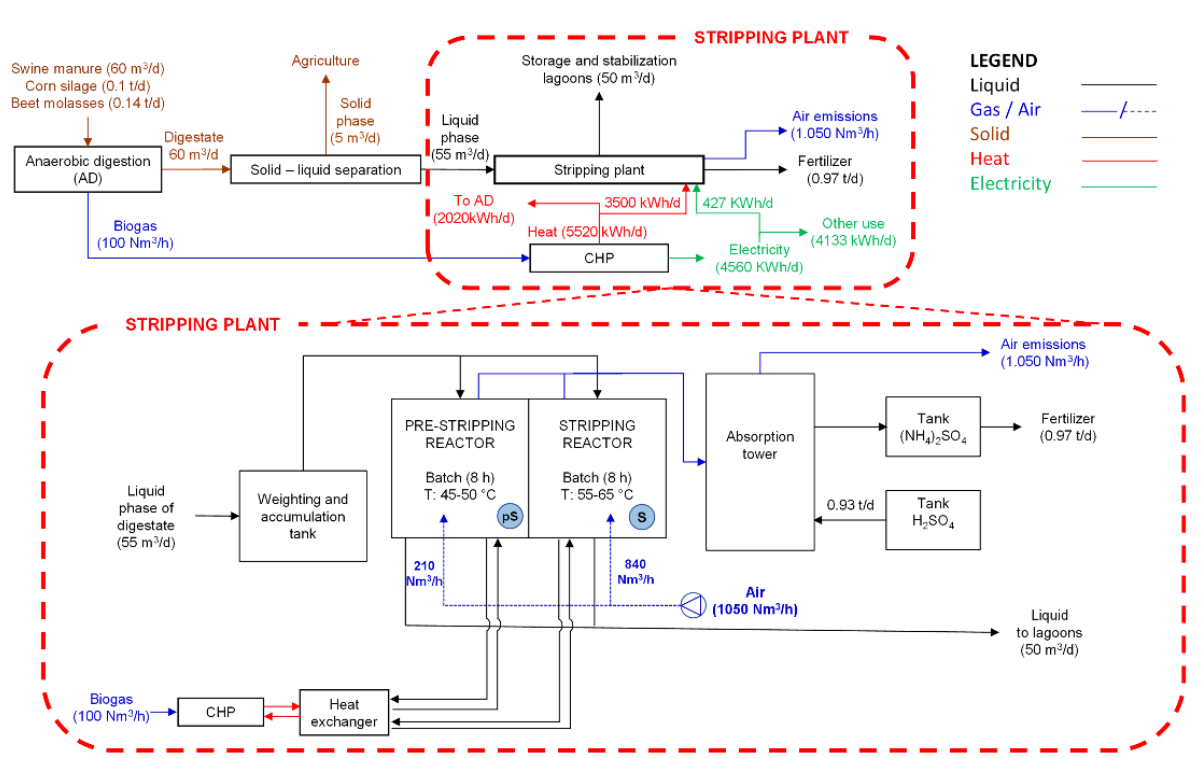
Figure 1. Scheme of the treatment plant with a focus on the stripping system and sampling points (pS and S). The mass and energy flows are referred to the current operating